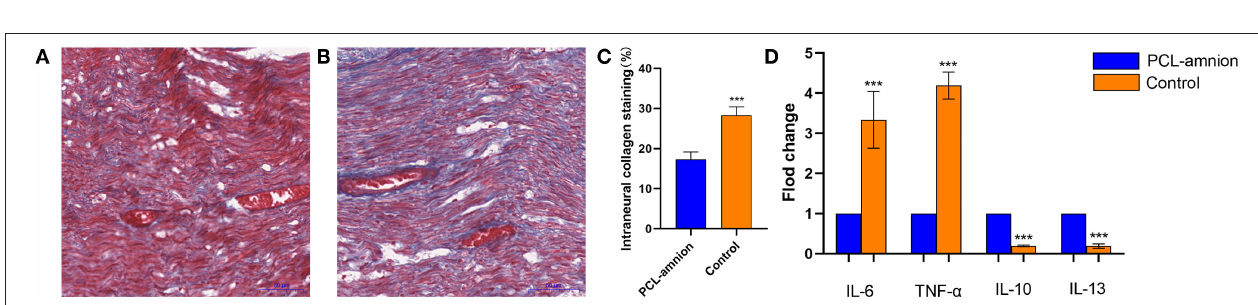
FIGURE 3 | Collagen deposition and quantification of cytokine expression at the repair site. (A) The PCL-amnion nanofibrous membrane group. (B) The Control group. (C) Quantification of collagen at the repair site between the two groups were significantly different ( P < 0.05). (D) The gene expression of proinflammatory cytokines IL6 and TNF-a decreased, and the gene expression of anti-inflammatory cytokines IL10 and IL13 increased in the PCL-amnion nanofibrous membrane group ( P < 0.05 for each cytokine). *** P < 0.001 compared to the PCL-amnion group.